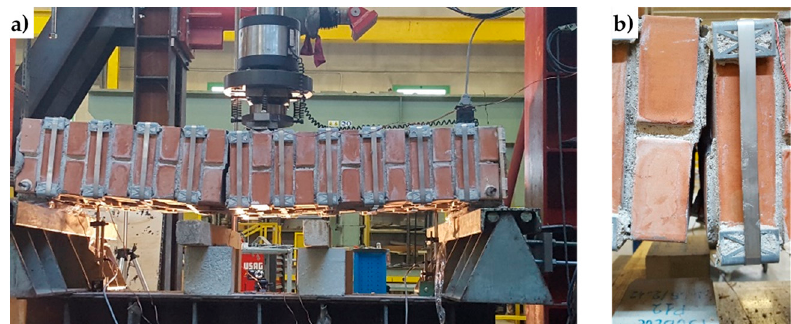
Figure 48. Specimen W3 at the end of the flexural test: ( a ) overview and ( b ) the failure cross-section, where the crack propagation occurred in both Mode I (opening mode) and Mode II (sliding mode). Materials 2019 , 12 , x FOR PEER REVIEW